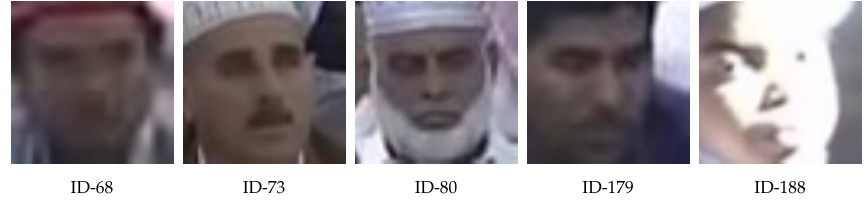
Figure 13. Sampled personal images of size 50 ×